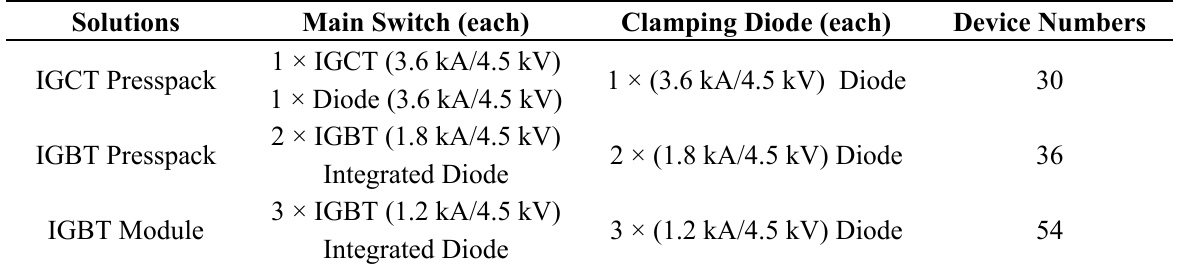
Table 3. Three power switching device solutions for 10 MW 3L-NPC converter. Solutions Main Switch (each) Clamping Diode (each) Device Numbers IGCT